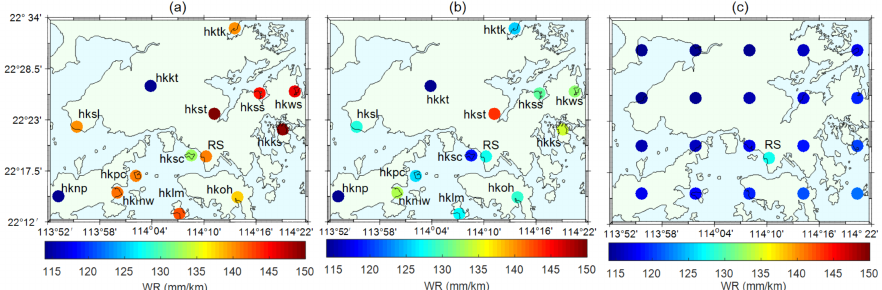
Figure 8. Wet refractivity from GNSS meteorological data, radiosonde and ECMWF at 0:00 UTC on 20 July 2015. ( a ) WR from ground GNSS meteorological data and RS; ( b ) GNSS meteorological data and RS data derived WR reduced to 400 m height; ( c ) ECMWF and RS WR reduced to 400 m